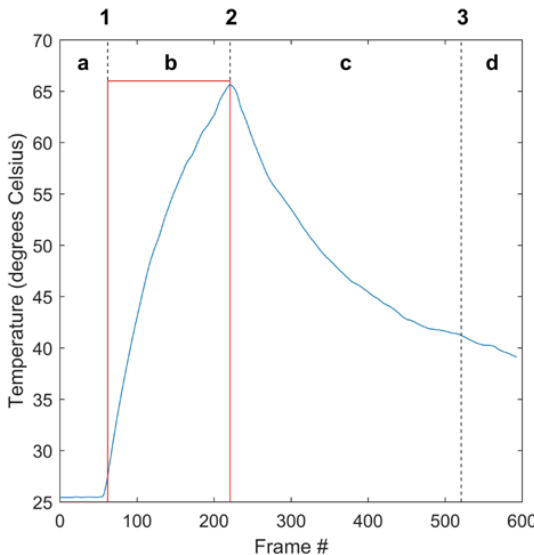
Figure 7. Segmented mean temperature waveform of cotton sample #4. ( a ) resting stage/front buffer; ( b ) thermal stimulation; ( c ) cooling; ( d ) rear buffer; ( 1 ) lamp activation; ( 2 ) lamp deactivation; ( 3 ) data cutoff. The red square wave represents the thermal stimulus provided by the heat lamps and shows the times of activation and deactivation. The magnitude of the square wave is here arbitrary.